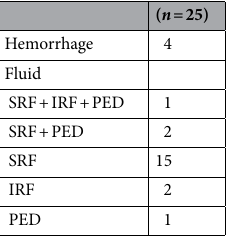
Table 2. Macular findings on OCT determined at recurrence after cessation. IRF, intraretinal fluid; OCT, optical coherence tomography; PED, pigment epithelial detachment; SRF, subretinal